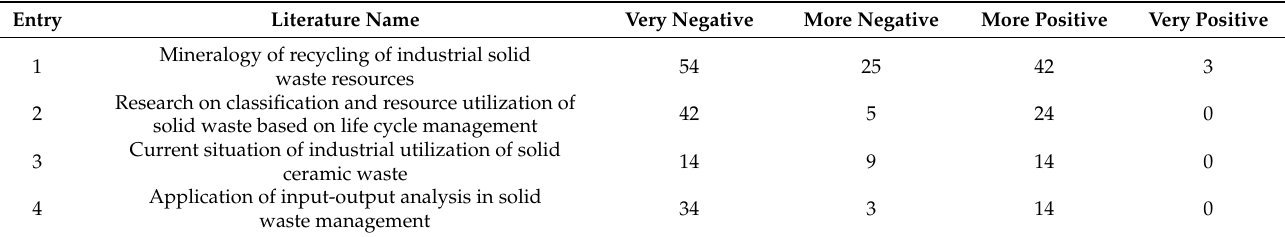
Table 1. Summary of automatic coding of emotional results.